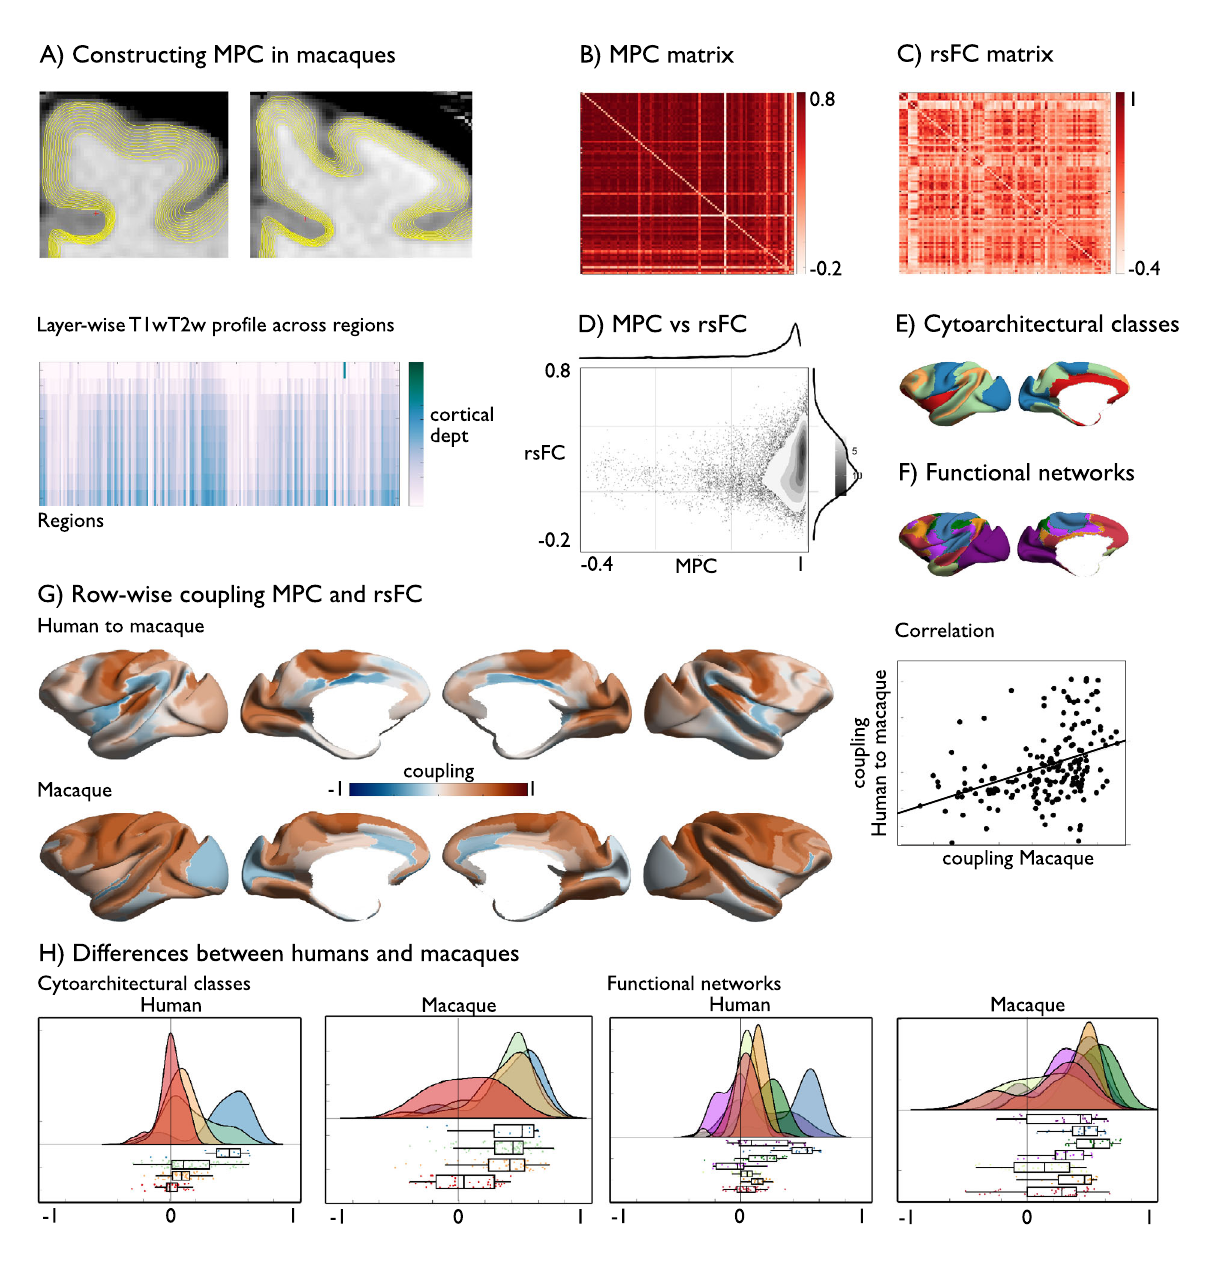
Fig. 3 Microstructure-function coupling in macaques. A Creating MPC in macaques; B MPC matrix in macaques, ordered along cytoarchitectural class based on ref. 59 and Markov labels 116 ; C rsFC matrix in macaques, ordered along cytoarchitectural class; D Correspondence between MPC and rsFC in macaques; E Cytoarchitectural classes; F Functional communities based on ref. 28 ; G Row-wise association of MPC and rsFC; upper panel: human map in macaque space; lower panel: macaque map; right: scatter between human and macaque MPC-rsFC coupling; H Raincloud plots of coupling in humans and macaques as a function of cytoarchitectural class and functional communities 28 in macaque space (182 parcels of Markov parcellation), boxes show the median and interquartile (25 – 75%) range, whiskers depict the 1.5*IQR from the quartile. Source data are provided as a Source Data fi